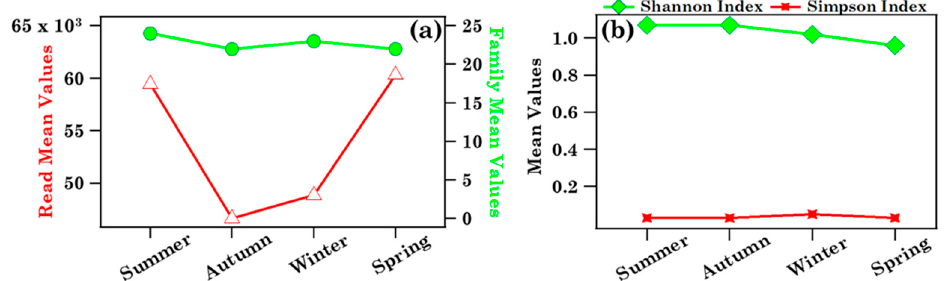
Figure 11. Mean values of ( a ) the number of Streptophyta reads (open red triangles) and families (full green dots) and ( b ) Shannon (green diamonds) and Simpson (red stars) indices at the family level in Lecce across the four seasons: summer (July, August, September), autumn (October, November, December), winter (January, February, March), and spring (April, May, June). Solid lines join the discrete data points to better visualise their respective seasonal trend.